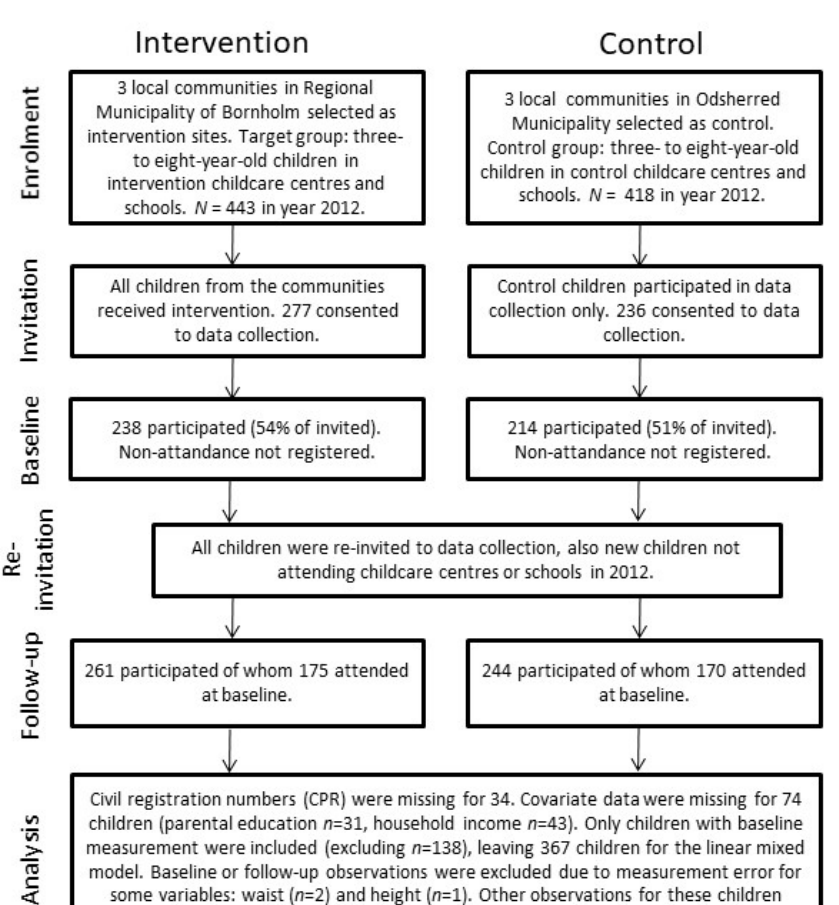
Figure 1. Flow diagram of recruitment and analysis.